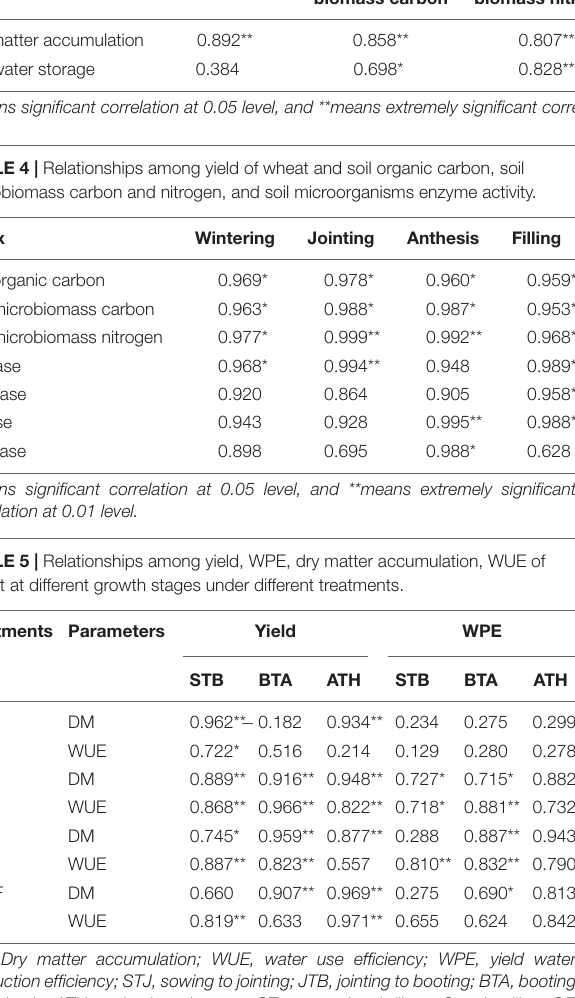
TABLE 3 | Relationships among dry matter accumulation, soil water storage and soil organic carbon, soil microbiomass carbon and nitrogen, and soil enzyme activity.